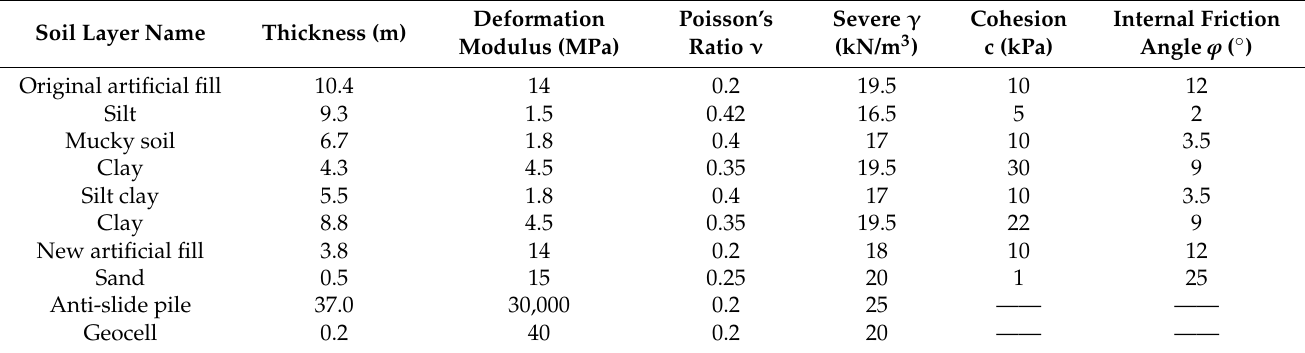
Table 1. The material properties of the riverbank slope’s soil, anti-slide piles and geocells.